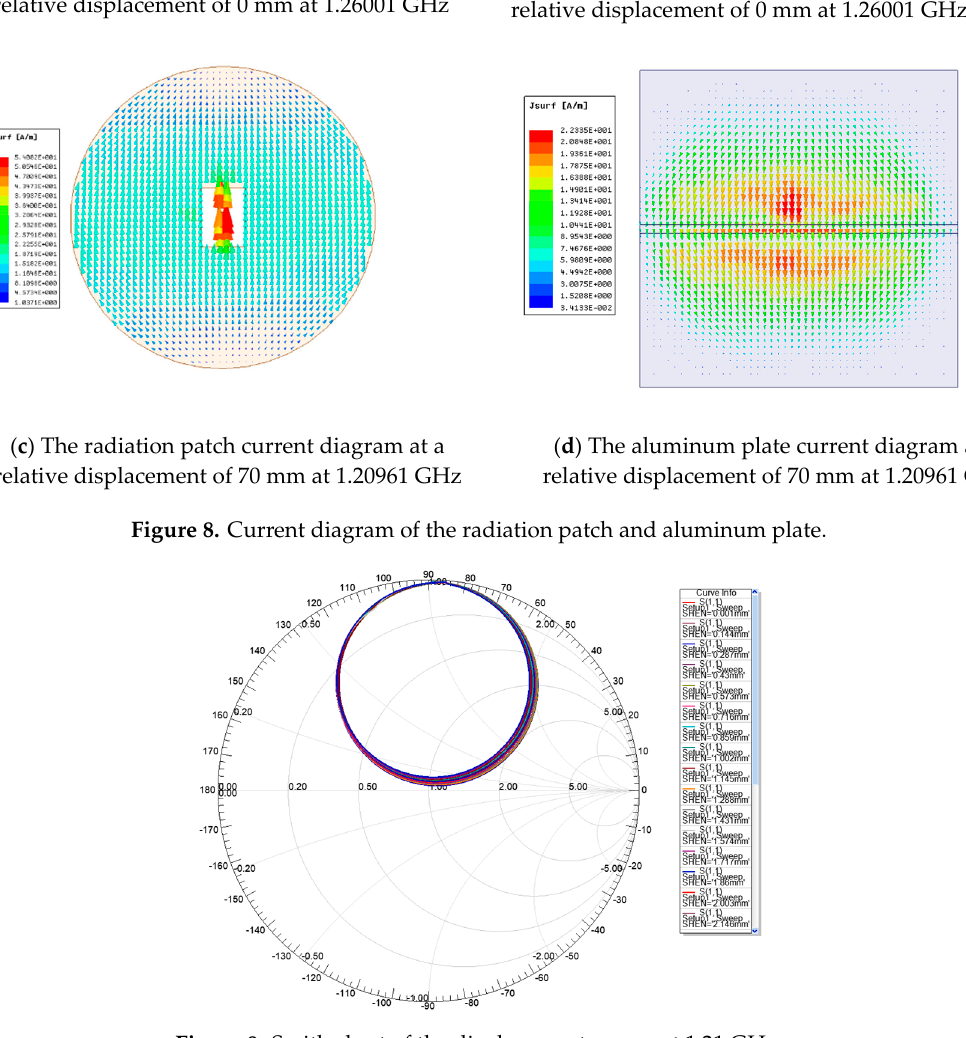
Figure 9. Smith chart of the displacement sensor at 1.21 GHz.